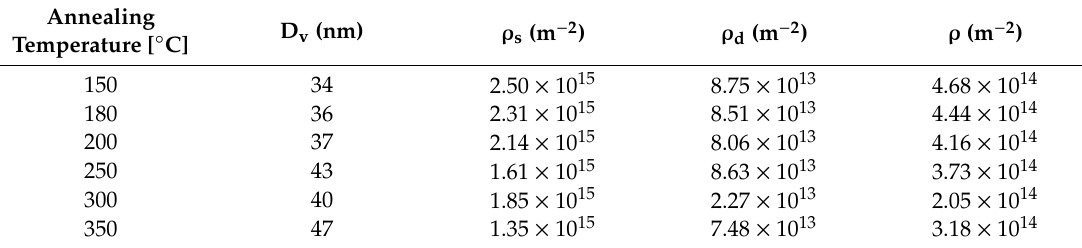
Table 5. Structural parameters of the DRECE processed and annealed 5754 aluminum alloy determined by X-ray di ff raction peak analysis. D v = domain size; ρ d = dislocation density due to lattice microstrain;